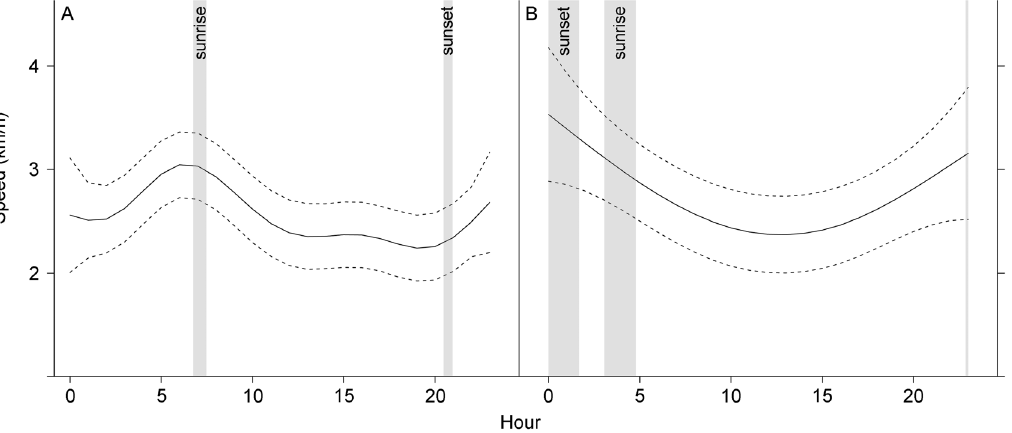
Figure 6. GAM estimate of ARS speed of fin whales during 24-hours in each geographic area. A. Azores area. B. area north of 56 u N. Solid line represents the estimate and dashed lines the estimate 6 2 SE. Grey areas correspond to sunrise and sunset intervals (mean 6